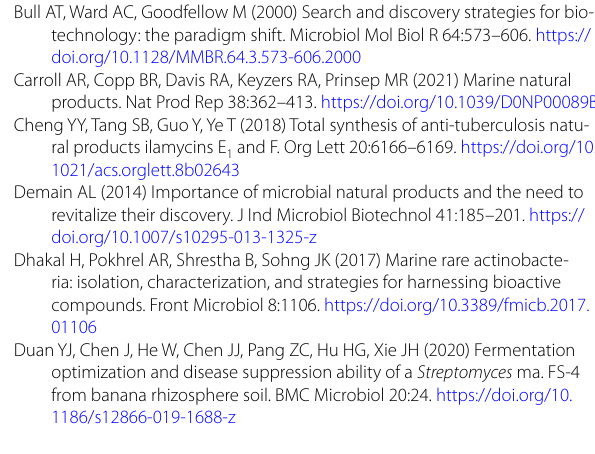
Additional file 1: Table S1. Seven kinds of fermentation medium. Table S2. Factors and levels used in Plackett–Burman design. Table S3. Design and results of Plackett–Burman experiments. Table S4. Factors and levels used in Central Composite Design. Table S5. Design and results